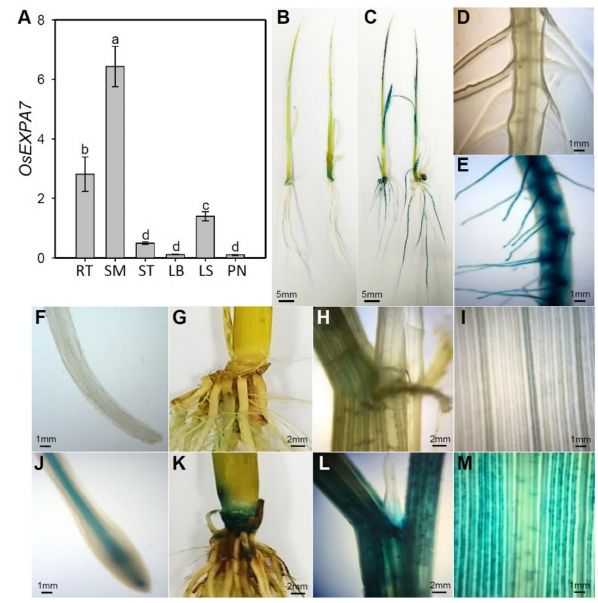
Figure 3. Tissue-specific spatial expression of OsEXPA7 by histochemical and qRT-PCR analyses. ( A ) qRT-PCR analysis of OsEXPA7 in various organs. Total RNA was extracted from the root (RT), shoot apical meristem (SM), stem (ST), leaf blade (LB), and leaf sheath (LS) of two-week-old plants and from the panicle (PN) of plants one week after heading. ( B – M ) WT and OsEXPA7: GUS transgenic rice plants were used for GUS analysis. GUS activity was detected in whole seedlings of WT ( B ) and OsEXPA7: GUS ( C ), root hairs of WT ( D ) and OsEXPA7: GUS ( E ), root tip of WT ( F ) and OsEXPA7: GUS ( J ), SAM of WT ( G ) and OsEXPA7: GUS ( K ), leaf sheath of WT ( H ) and OsEXPA7: GUS ( L ), and leaf blade of WT ( I ) and OsEXPA7: GUS ( M ). Di ff erent letters indicate significant di ff erences, according to one-way ANOVA and Duncan’s least significant range test ( p < 0.05). Photographs shown in (B–M)